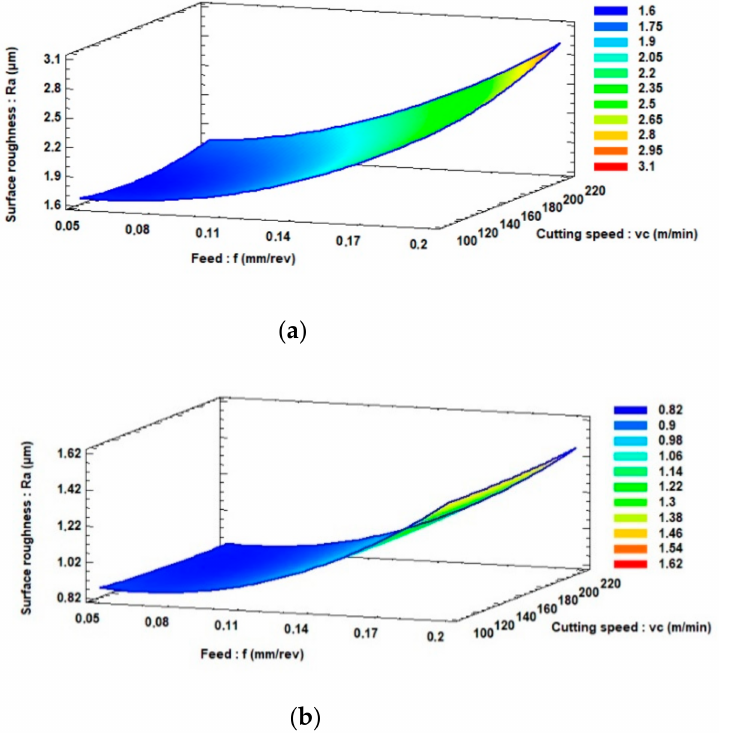
Figure 5. Response surface as a function of feed and cutting speed when lubrication is used